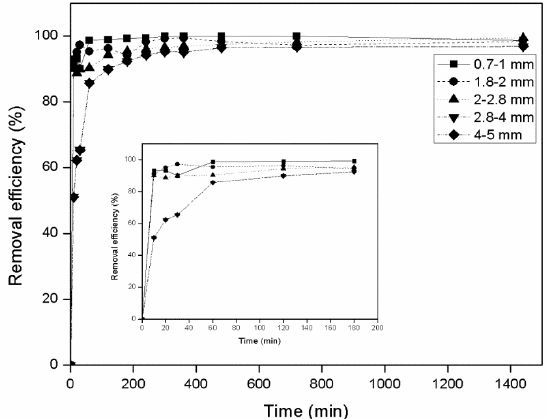
Figure 1. Effect of zeolite particle size on ammonium removal (5 mg/L NH 4+ -N, T = 25 °C, 200 rpm, 50 g zeolite/L). Error bars indicate standard deviation of triplicate measurements.